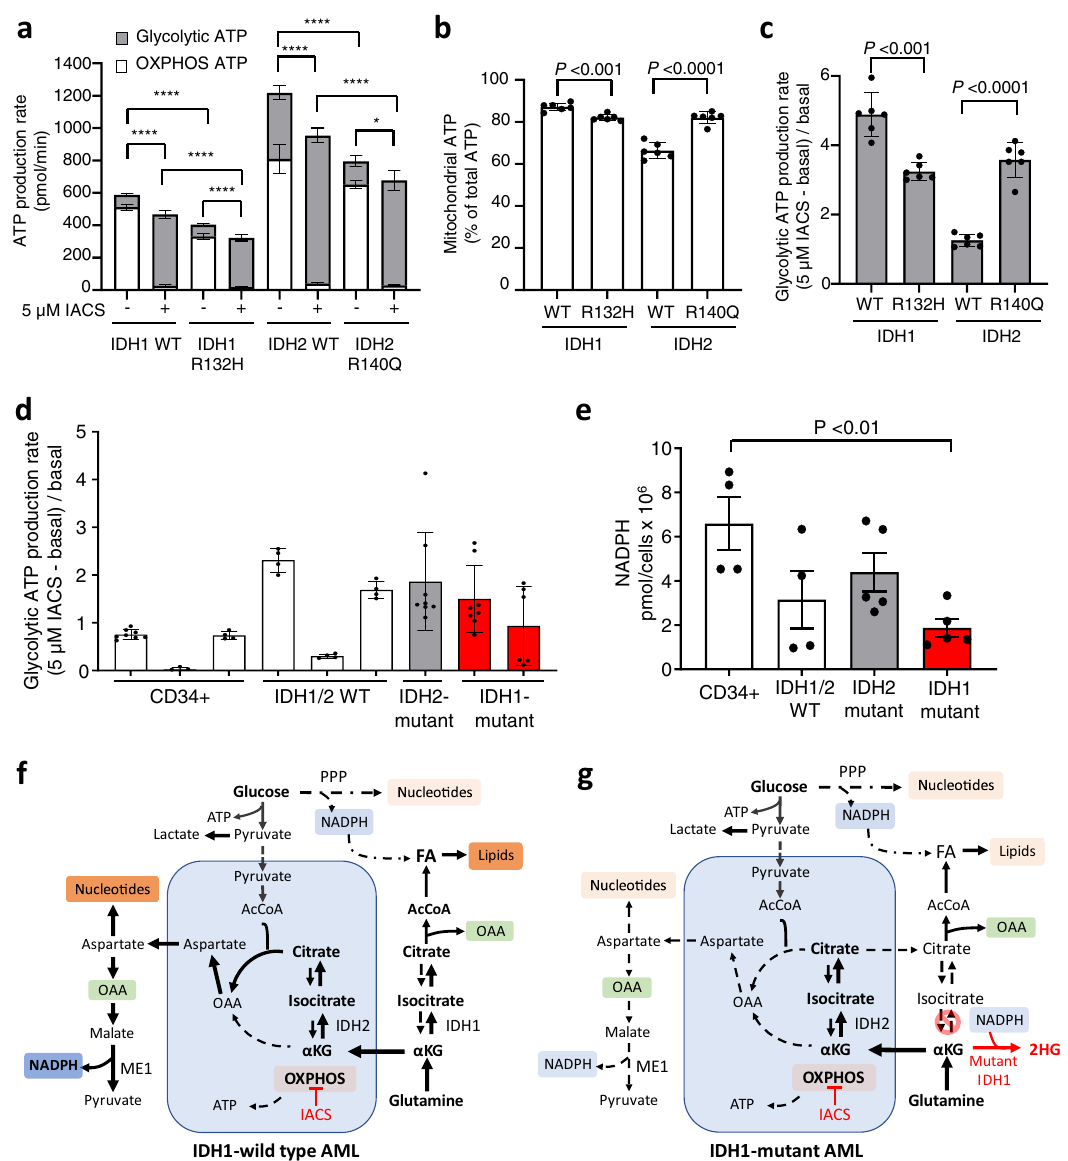
Fig. 4 Metabolic plasticity of IDH1 -mutant AML. a Total ATP production rate at basal and following induction with 5 µ M IACS-010759 (IACS) for isogenic THP1 cells expressing IDH1 wildtype (WT), IDH1 R132H, IDH2-WT or IDH2 R140Q, measured by ATP rate assay. Contribution to ATP production rate from glycolysis (grey) and OXPHOS (white) are shown as mean ± SD of six technical replicates. Statistical signi fi cance determined by one-way ANOVA (Tukey ’ s multiple correction), **** P < 0.0001 and * P = 0.029. b Mitochondrial ATP as a percentage of total ATP in untreated isogenic THP1 cells shown as mean ± SD of six technical replicates. Signi fi cance determined by two-tailed unpaired t -test, P = 0.0005 (IDH1-WT vs. IDH1 R132H) and P < 0.0001 (IDH2- WT vs. IDH2 R140Q). c Change in glycolytic ATP following addition of 5 µ M IACS-10759 (IACS) relative to basal glycolytic ATP production rate, measured by ATP rate assay for isogenic THP1 cells. Data shown as mean ± SD of six technical replicates. Signi fi cance determined by two-tailed unpaired t -test, P = 0.0001 (IDH1-WT vs. IDH1 R132H) and P < 0.0001 (IDH2-WT vs. IDH2 R140Q). Raw oxygen consumption rate (OCR) and extracellular acidi fi cation rate (ECAR) data related to ( a – c ) are presented in Supplementary Fig. 6a, b. d Change in glycolytic ATP following addition of 5 µ M IACS-10759 relative to the basal glycolytic ATP production rate, for healthy CD34 + samples ( n = 3), IDH1/2 WT ( n = 3), IDH2- ( n = 1) or IDH1- mutant ( n = 2) AML. Data presented as mean ± SD of four or more technical replicates per sample, no signi fi cance was observed between groups. Individual sample results in Supplementary Fig. 7. e NADPH levels in CD34 + samples ( n = 4), IDH1/2 WT ( n = 4), IDH2- ( n = 5) or IDH1- mutant ( n = 5) AML. Data presented as mean of the group ± SEM. Each dot is the mean of an independent sample. Signi fi cance determined by one-way ANOVA (Dunnett ’ s multiple correction), signi fi cance P = 0.0091 (CD34 + vs. IDH1 mutant). Details of patient samples used in ( d ) and ( e ) are provided in Supplementary Data 5. Source data for ( a – e ) are provided in Source Data fi le. Schematic representation of metabolic rewiring of ( f ) IDH1 wild type AML and ( g ) IDH1 mutant AML following complex I inhibition. See text for explanation. Mitochondria shaded in blue. AcCoA acetyl CoA, FA fatty acid, IACS IACS-010759, IDH isocitrate dehydrogenase, ME1 malic enzyme 1, OAA oxaloacetic acid, OXPHOS oxidative phosphorylation, PPP pentose phosphate pathway, α KG alpha ketoglutarate, 2HG